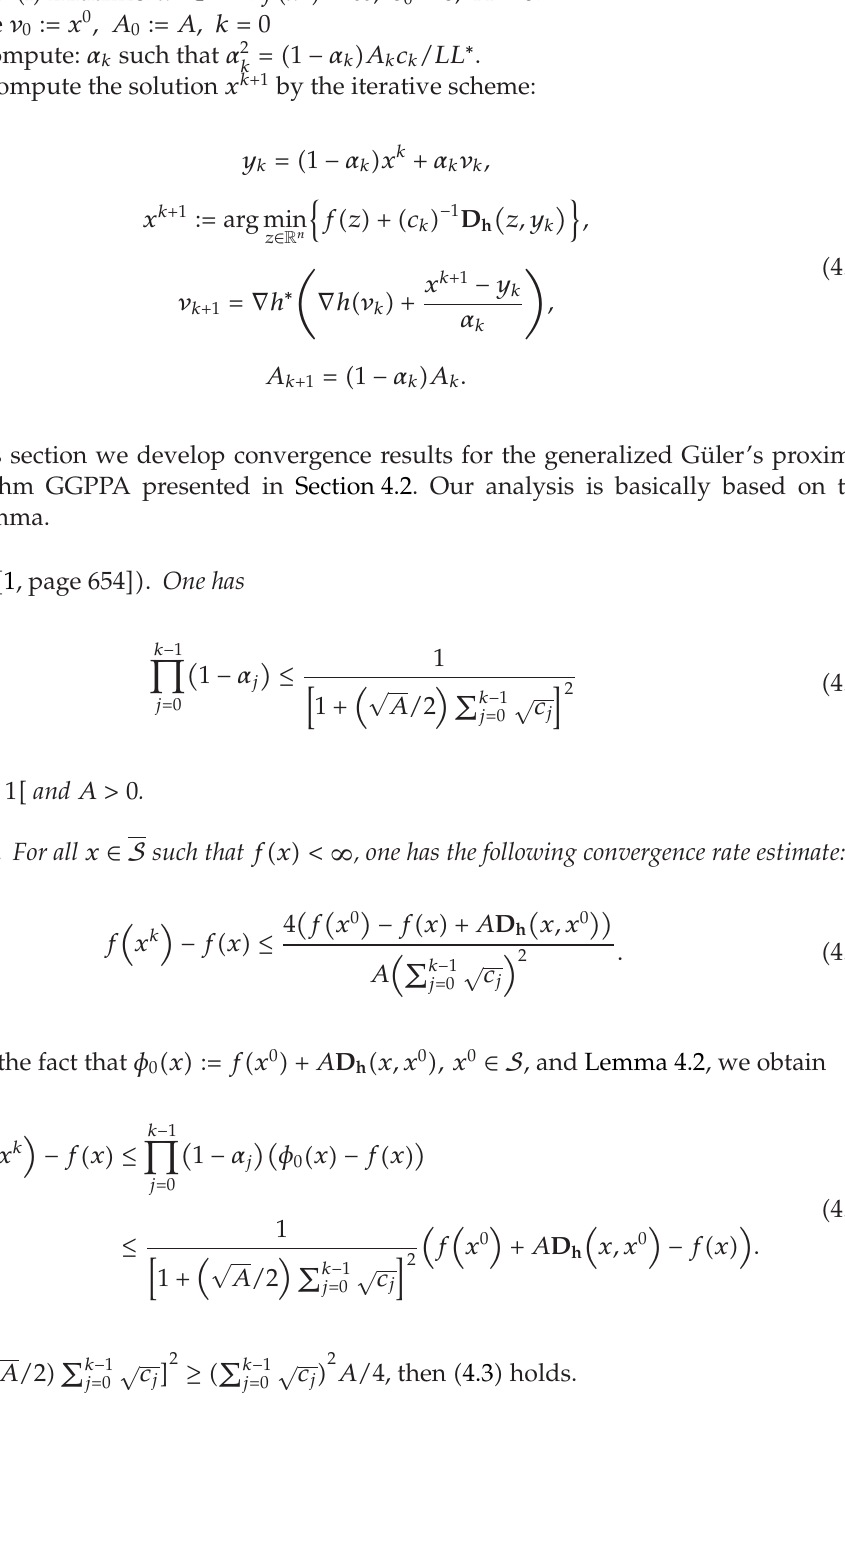
Algorithm 4.1. (cid:6) i (cid:7) Initialize: x 0 ∈ R n : f (cid:6) x 0 (cid:7) < ∞ , c 0 > 0 , A >